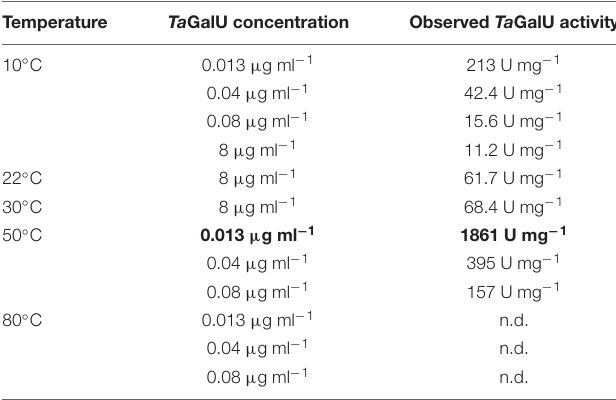
TABLE 2 | Initial tested conditions for the Ta GalU reaction and comparison of observed enzyme